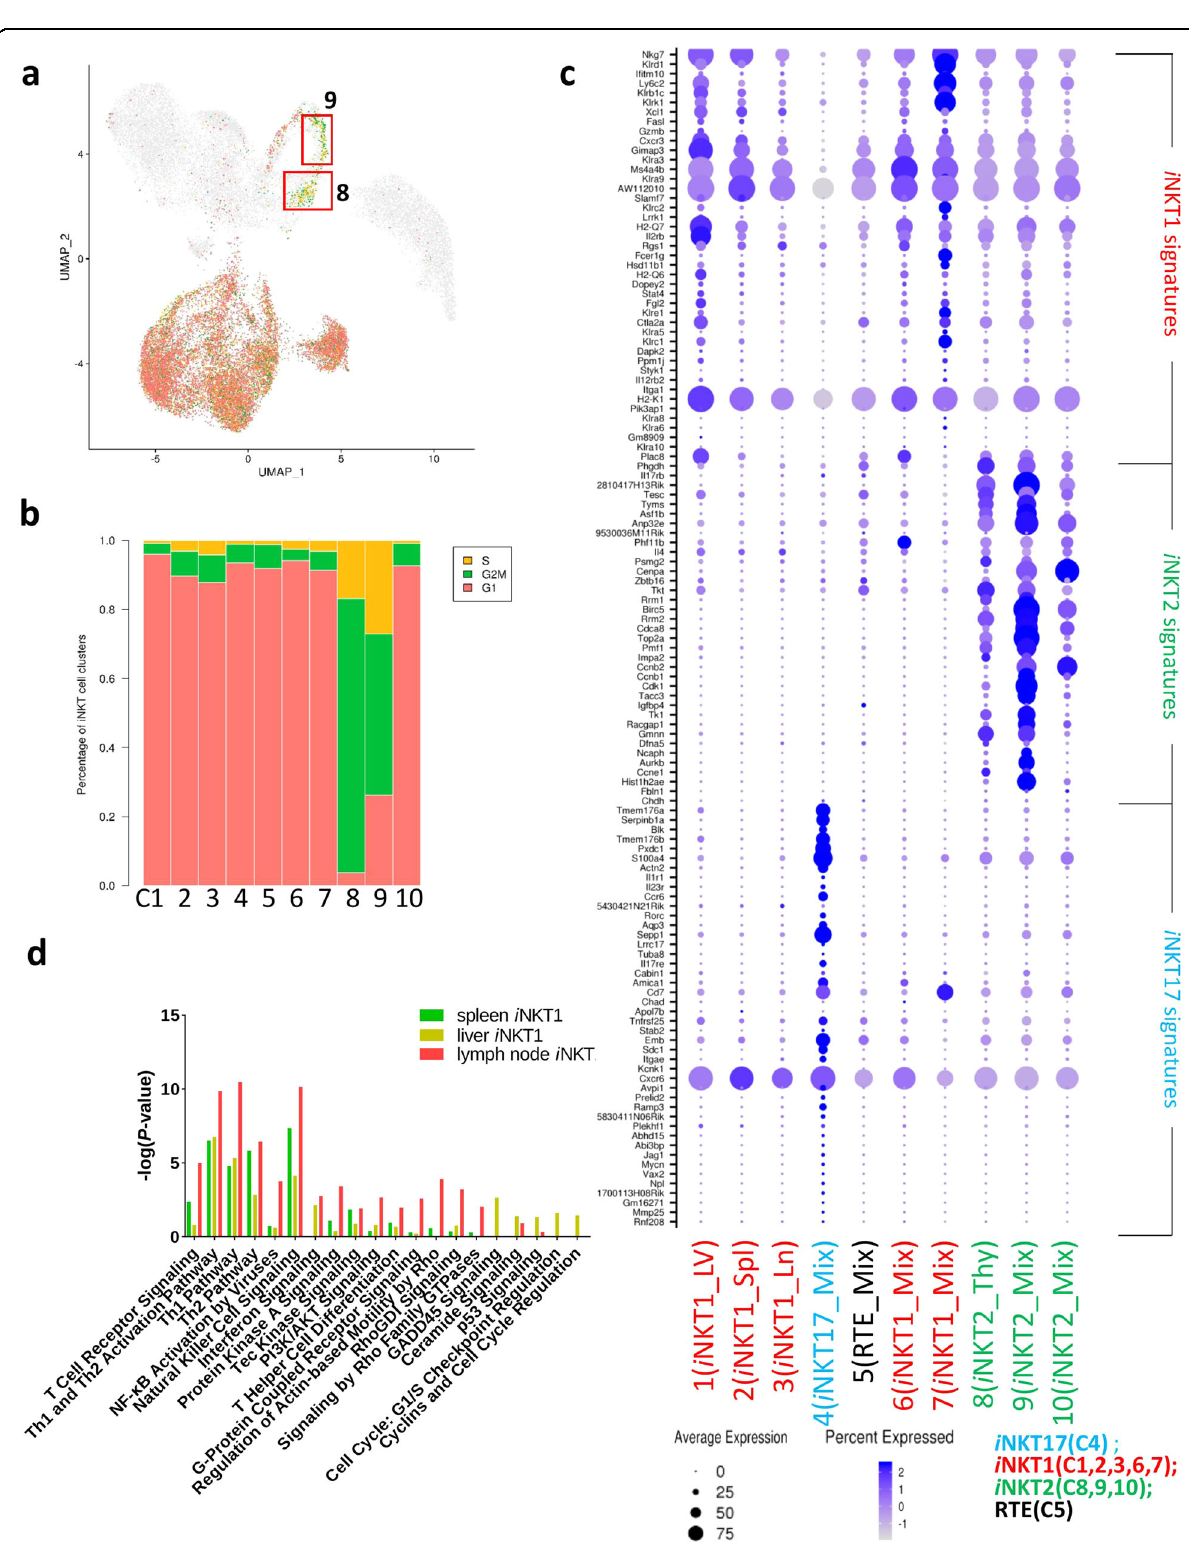
Fig. 2 Different clusters assigned into functional subsets. a UMAP plots depicting single-cell genes expression trajectory of G1, G2/M, and S phages in peripheral i NKT cell development. b Bar graph represents fraction of G1, G2/M, and S cells in i NKT cells clusters. c Bubble plots showing gene expression in individual clusters (C1 – C10) from aggregated i NKT cells. Gene names labeled in blue are i NKT17 signature genes, in red are i NKT1 signature genes and in green are i NKT2 signature genes. X axis shows different clusters identi fi ed in Fig. 1d. d Bar graph showing IPA analysis of i NKT1 cells in different peripheral